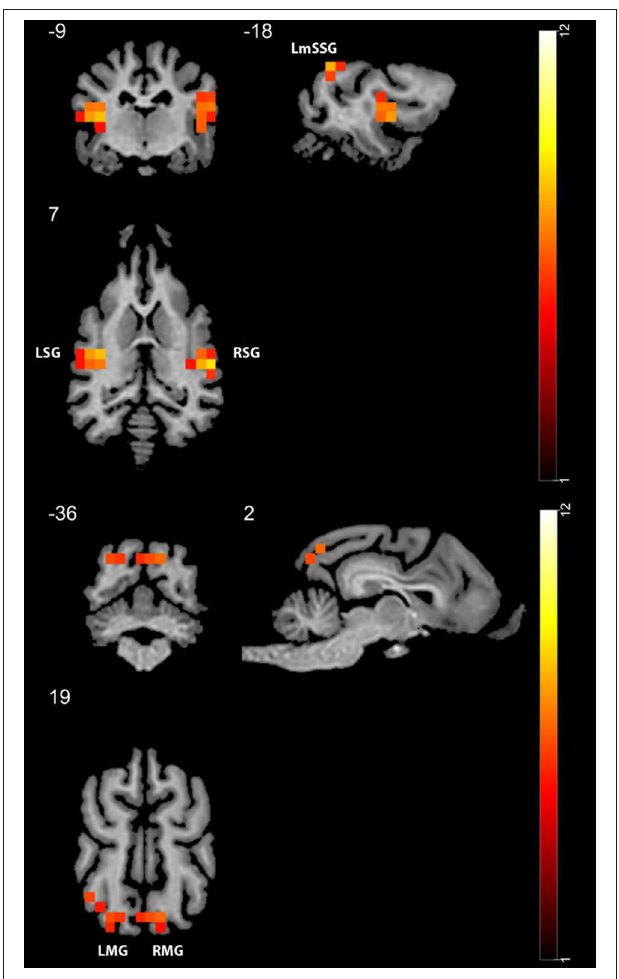
FIGURE 4 | GLM results in study 1 ( n = 13). Regions showing higher activity to the face stimulus compared to the mono-colored control. Color heatmap and color bar indicates t -values, displayed on selected slices overlaid on the template brain. Thresholdet at uncorrected voxel threshold p < 0.0001, FWE corrected at the cluster level. RSG, right Sylvian gyrus; LmSSG, left mid suprasylvian gyrus; LMG, left marginal gyrus; RMG, right marginal gyrus; LSG, left Sylvian